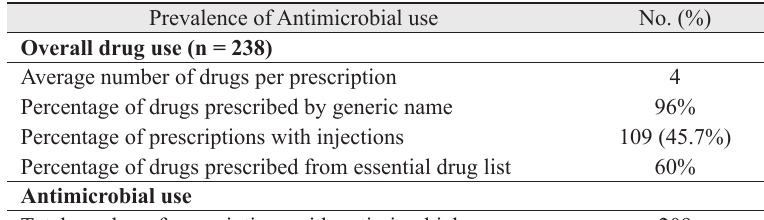
Figure 1 - Commonly prescribed drug classes in acute tonsillitis. Prevalence and indicators of antimicrobial